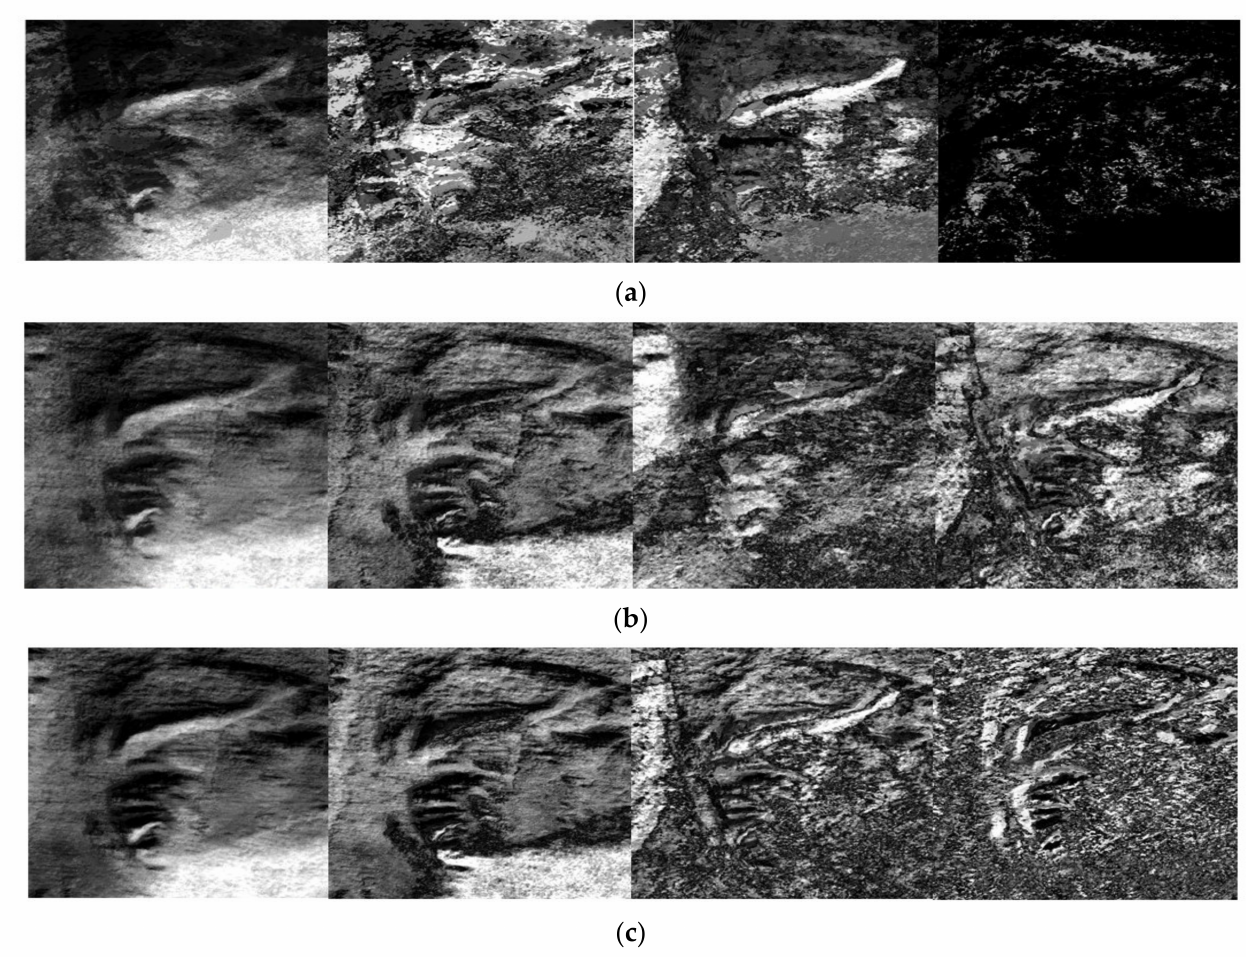
Figure 16. Rows ( a – c ) of the images correspond to the first four principal component vectors, which were extracted by low-rank decomposition from 9 local images of the first row in Figure 6a, all 18 local images in Figures 6a and 17 local images (excluding severely outlier block images after coarse registration by CCFR) in Figure 6a, respectively. Each block size is 600 × 650